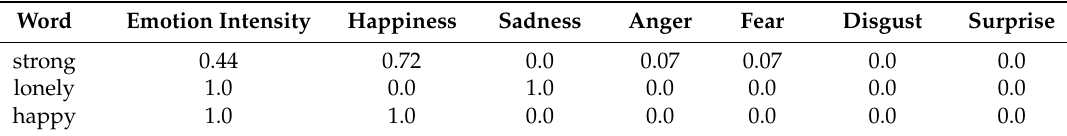
Table 3. Sample annotations of words from the Synesketch lexicon.